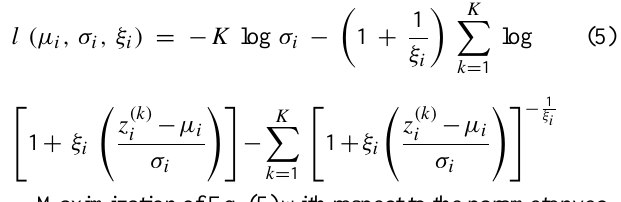
Fig. 4. Pointwise 50-year snow depth return level map (in centimeters).